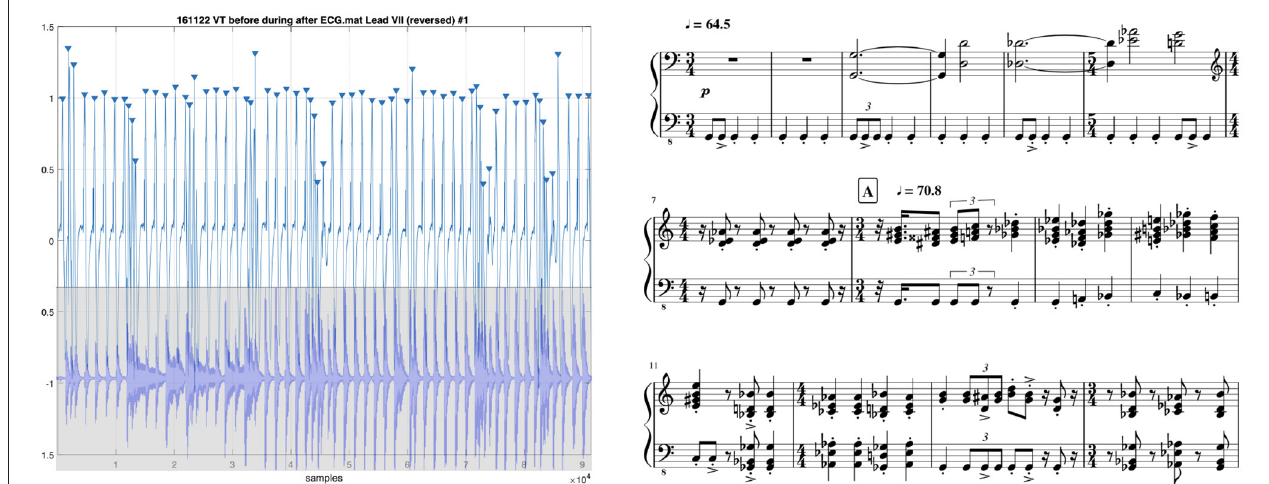
FIGURE 2 | Arrhythmia suite I: VT before during after (2017), after Mars, the bringer of war (1914), from the Planets, Op.32. Composition by Holst/Chew, Krishna, Soberanes, Ybarra, Orini, and Lambiase. (Left) ECG signal overlaid with audio of performance of (right) beginning of piece.